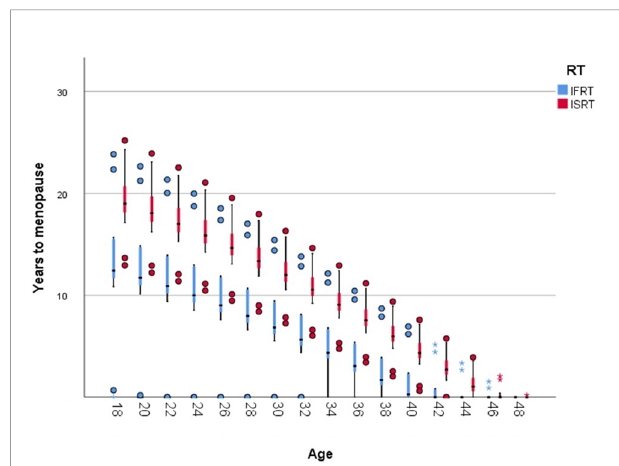
FIGURE 3 | Time to menopause by age and RT-Field; Boxplot (minimum, fi rst quartile, median, third quartile, and maximum; Dots represent outliers greater or less than the 1.5 x interquartile